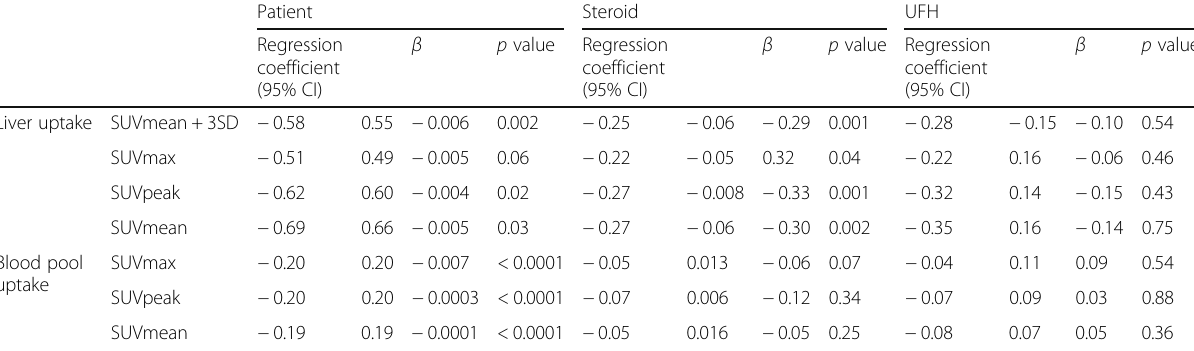
Table 5 The effect of UFH for the thresholds: multiple regression